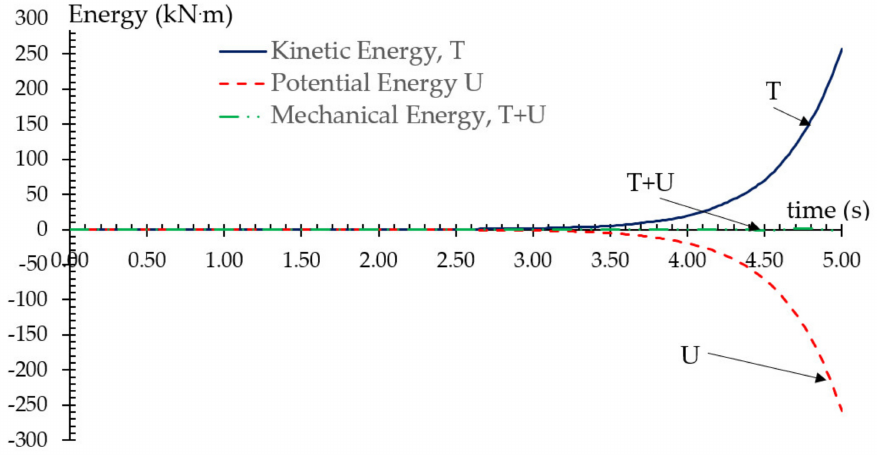
Figure 9. Potential energy competes with kinetic energy resulting in the elimination of the mechanical energy of the SDOF system with negative